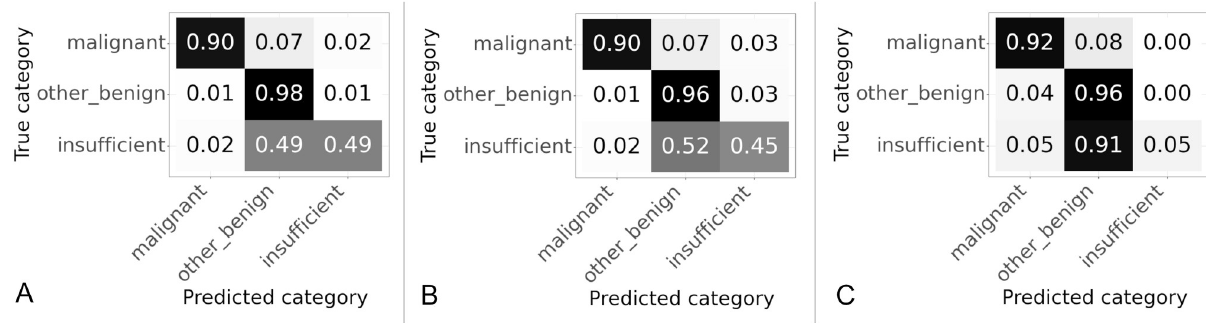
Fig 9. Confusion matrices for results on slide classifier described in Section 2.4.3. Values are normalized over the true category. (A) Slide classifier developed by Wang et al. (B) Slide classifier tuned for endometrial dataset. (C) Slide classifier based on CNN.